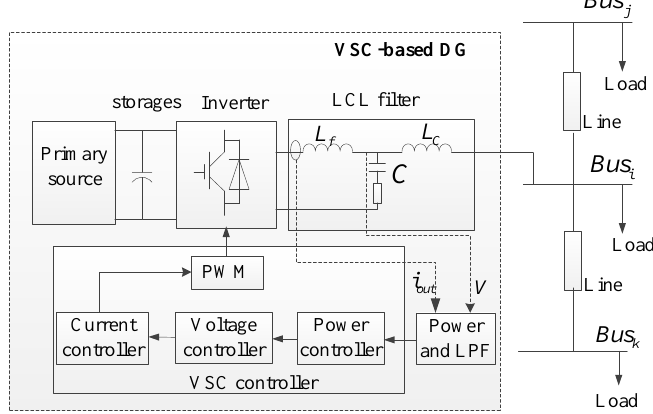
Figure 1. Typical structure of VSC-based DG.